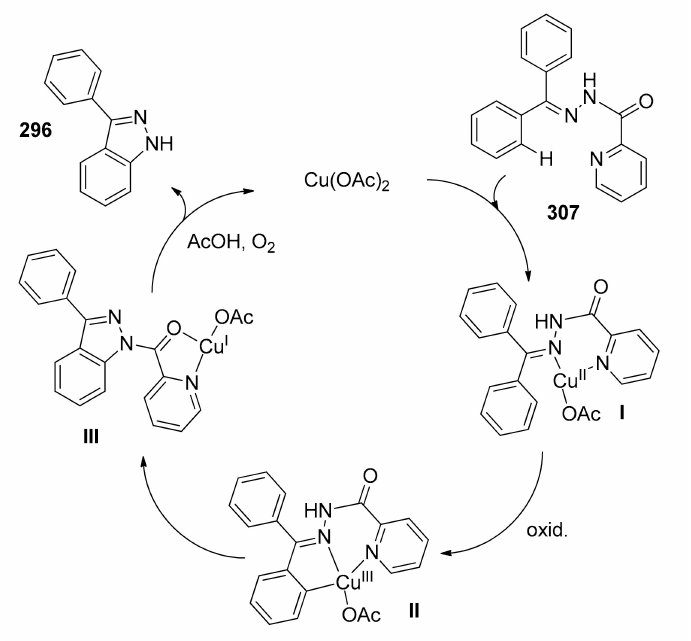
Scheme 26. Proposed mechanism of indazole synthesis from